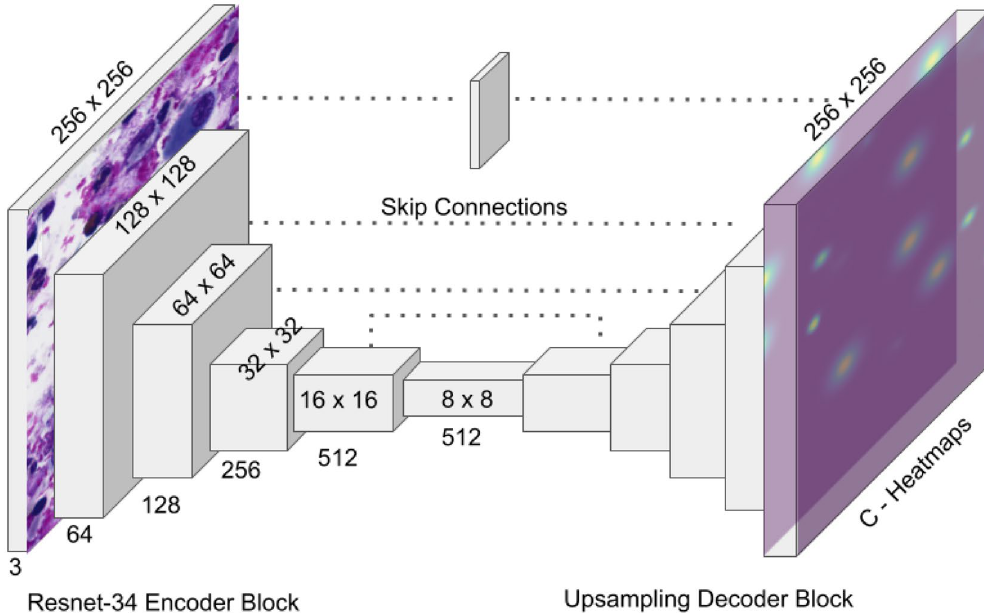
Figure 6. DCNet consists of a Resnet34 base encoder and 5 corresponding upsampling blocks. Input: 256 × 256 × 3 . Output: 256 × 256 × C